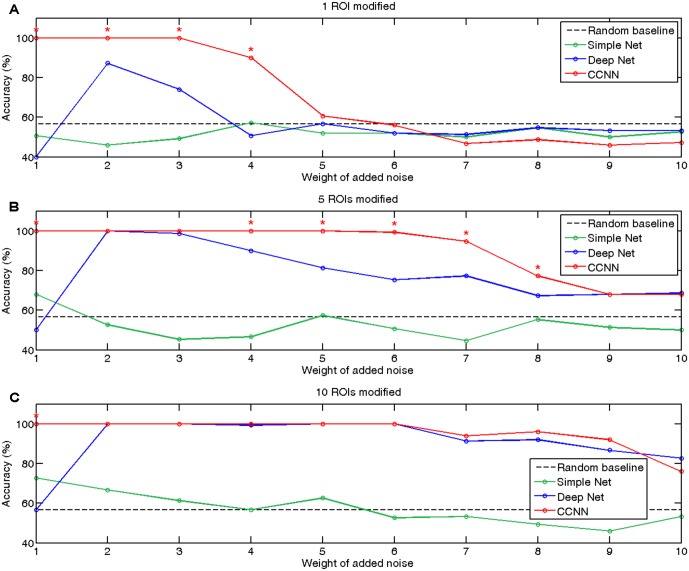
Accuracies of classification of simulated data with the simple (green), deep (blue), and connectome-convolutional (red) neural networks. The black dashed line represents the random baseline, significant (p < 0.05) differences between the deep and the connectome-convolutional networks’ results are denoted with red stars. (A) Classification accuracies on the dataset with one ROI modified. (B) Classification accuracies on the dataset with five ROIs modified. (C) Classification accuracies with 10 ROIs modified.